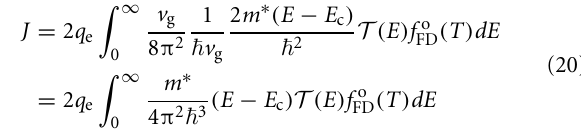
where H is the Heaviside function, E c is the lowest energy of the conduction band, m* is the effective mass in the parabolic band approximation,and E vac is the vacuum energy level (see Figure 2